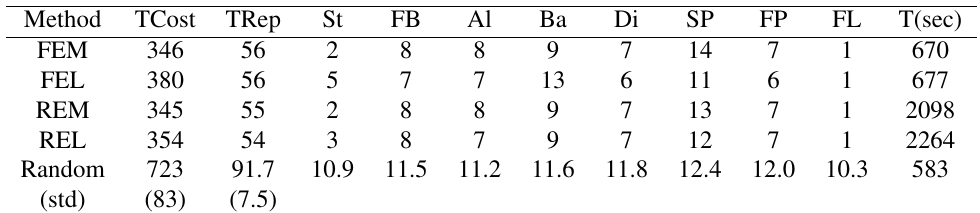
Table 3. DAP-TR results when threshold is 0.50.